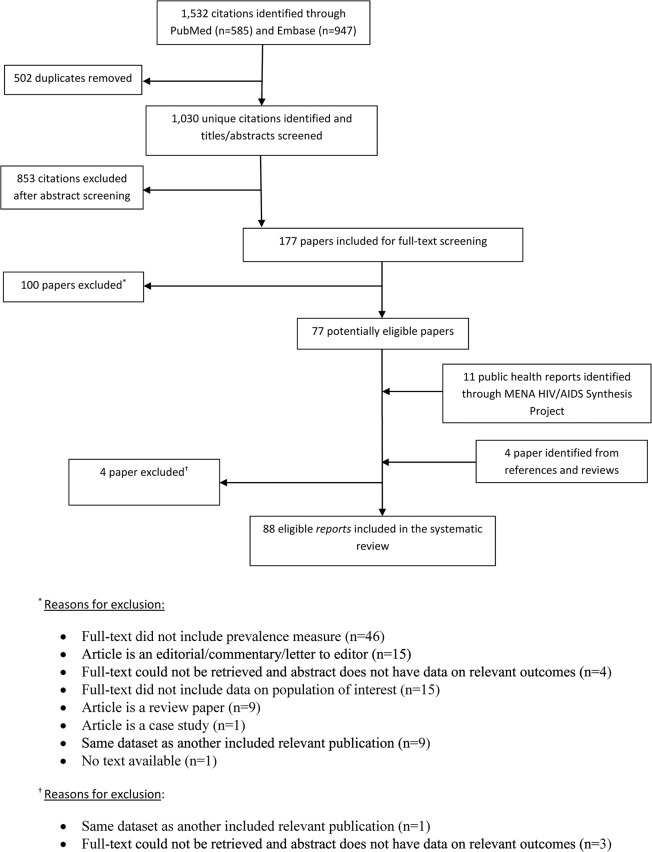
Flow chart of article selection adapted from the PRISMA 2009 guidelines [6].